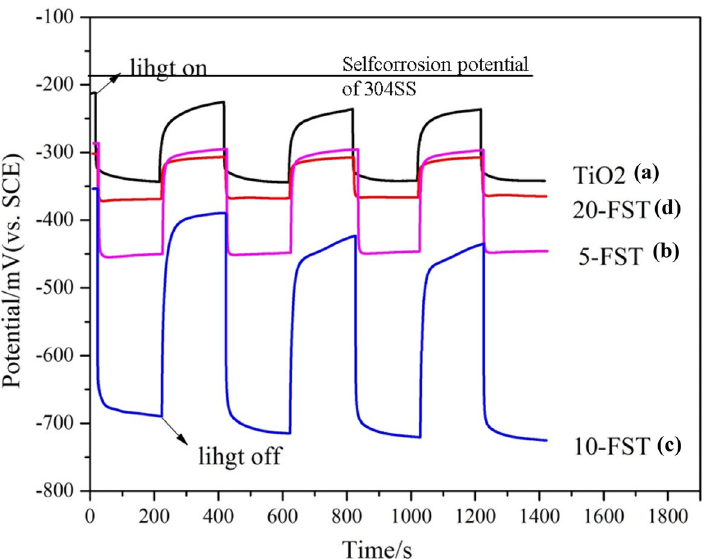
Figure 2. OCP of ( a ) pure TiO 2 , ( b ) 5-FST, ( c ) 10-FST, ( d )